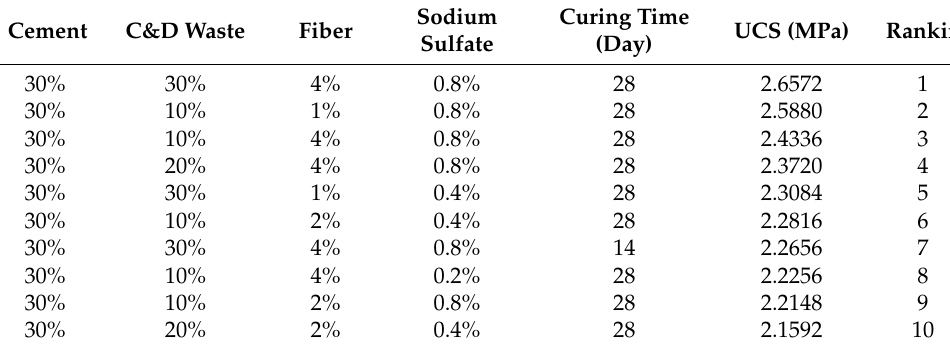
Table 5. Unconfined compressive strength